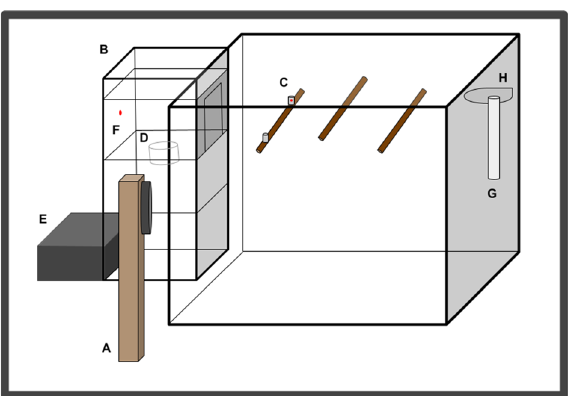
Figure 2. Illustration of the operant conditioning chamber, including: ( A ) speaker, ( B ) automated feeder, ( C ) request perch fitted with infrared photo-beam assembly, ( D ) feeder cup, ( E ) electrical inputs, ( F ) red LED, ( G ) water bottle, ( H ) and cuttlebone. Also shown is the feeder opening, and additional perches. To simplify, the sketch the front and floor of the chamber, and the enclosure’s acoustic lining are not